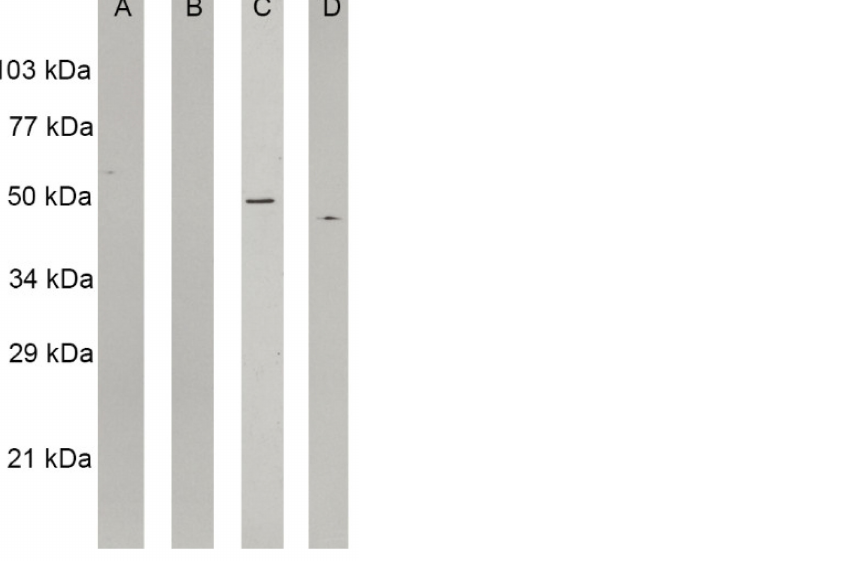
Figure 7. Western blot analyses of structural proteins on H. capsulatum protein extracts. Strips were revealed with commercial anti-actin or anti-tubulin monoclonal antibodies: ( A ) mebendazole-treated extract revealed with anti-tubulin antibody; ( B ) mebendazole-treated extract revealed with anti-actin antibody; ( C ) mebendazole-untreated extract revealed with anti-tubulin antibody, with a positive 50 kDa band; ( D ) mebendazole-untreated extract revealed with anti-actin antibody, with a weekly positive 42 kDa